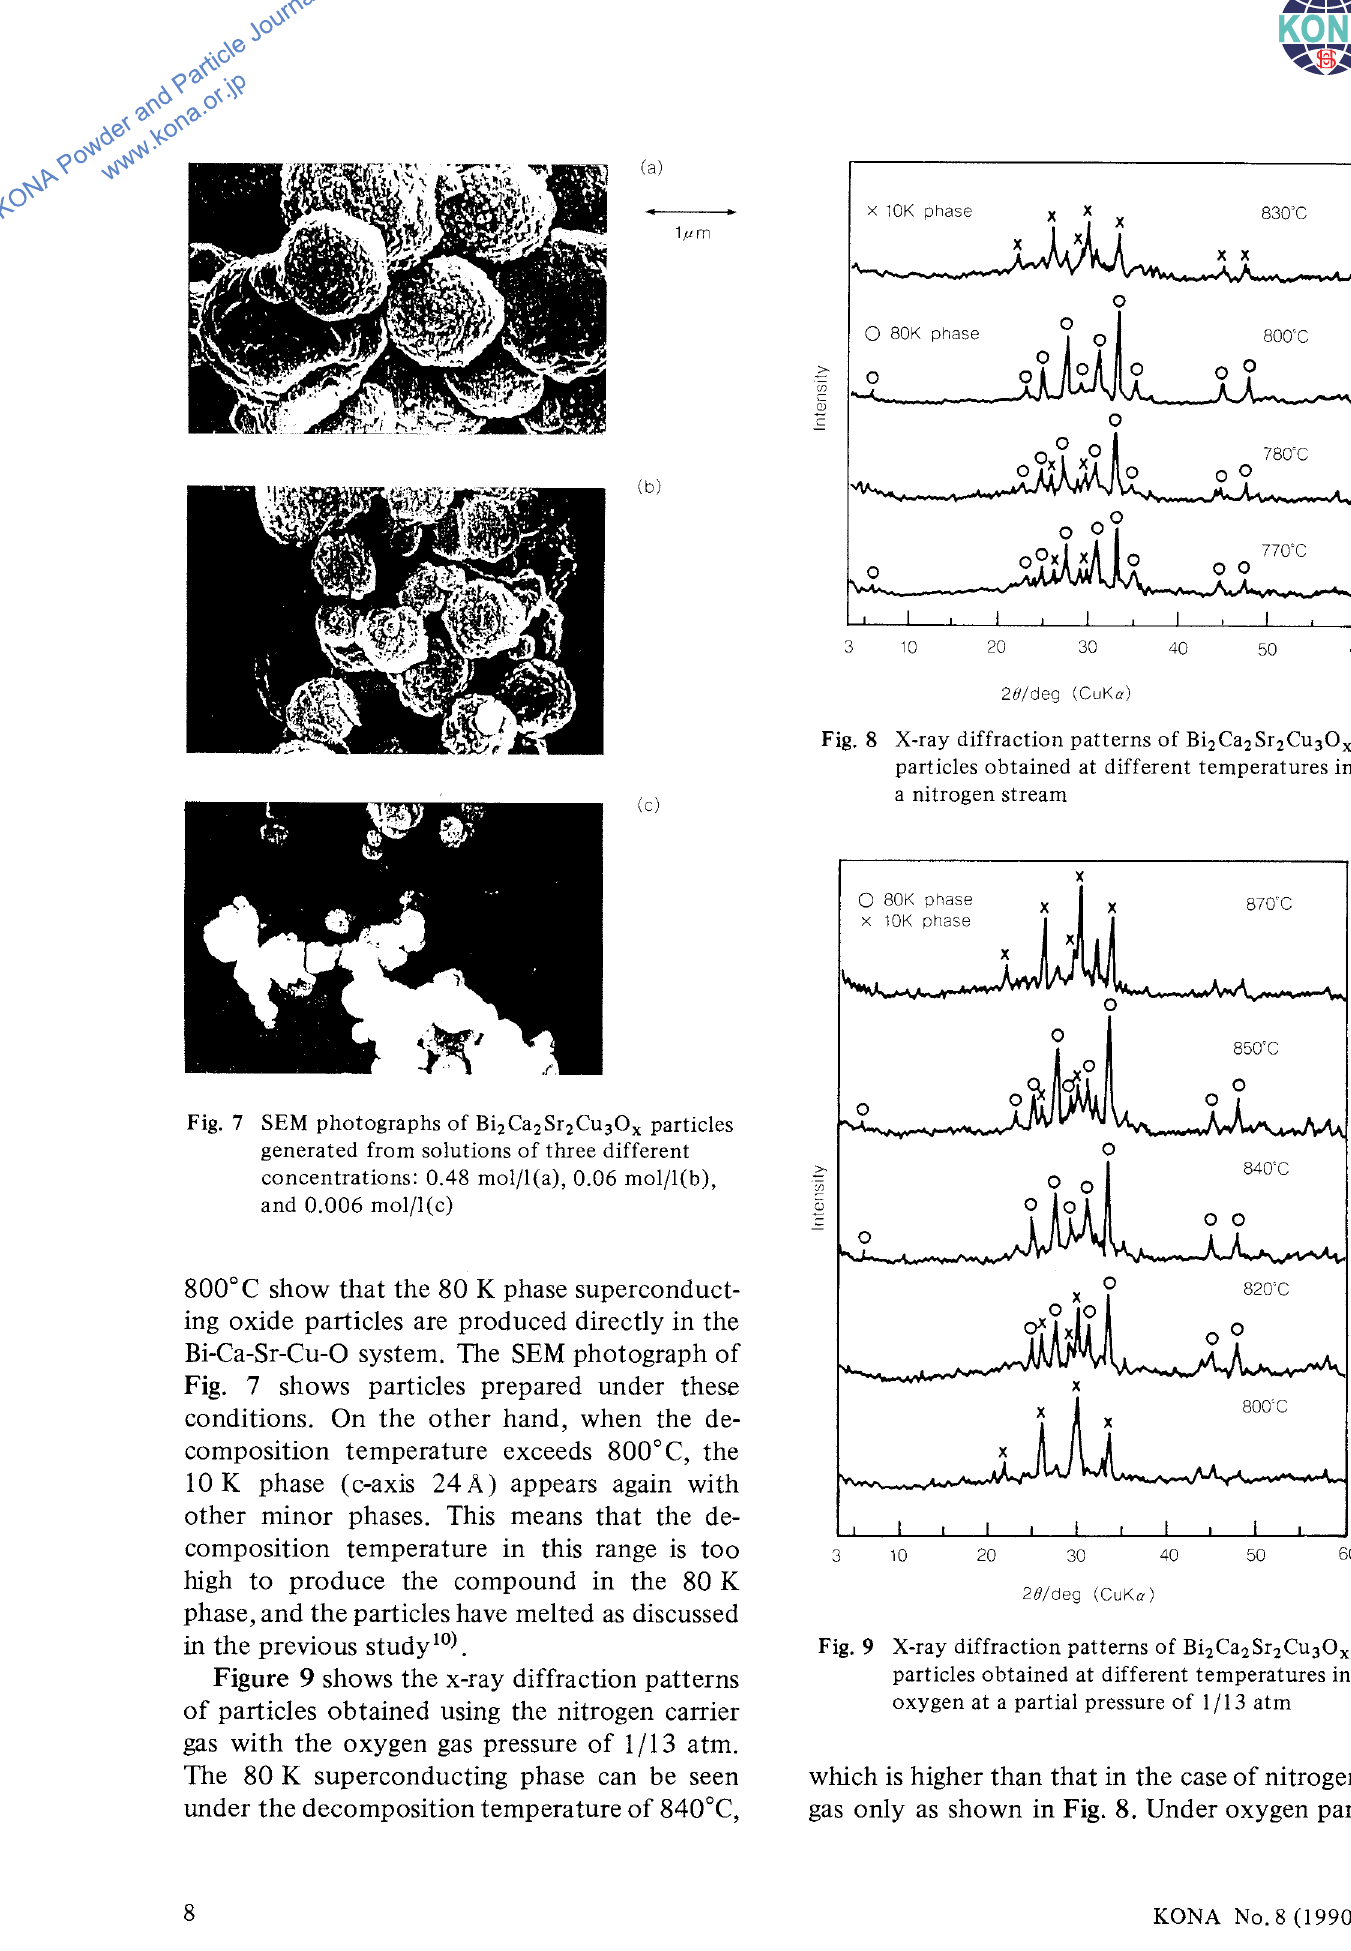
Fig. 9 X-ray diffraction patterns of Bi 2 Ca 2 Sr 2 Cu 3 0x particles obtained at different temperatures in oxygen at a partial pressure of 1 I 13